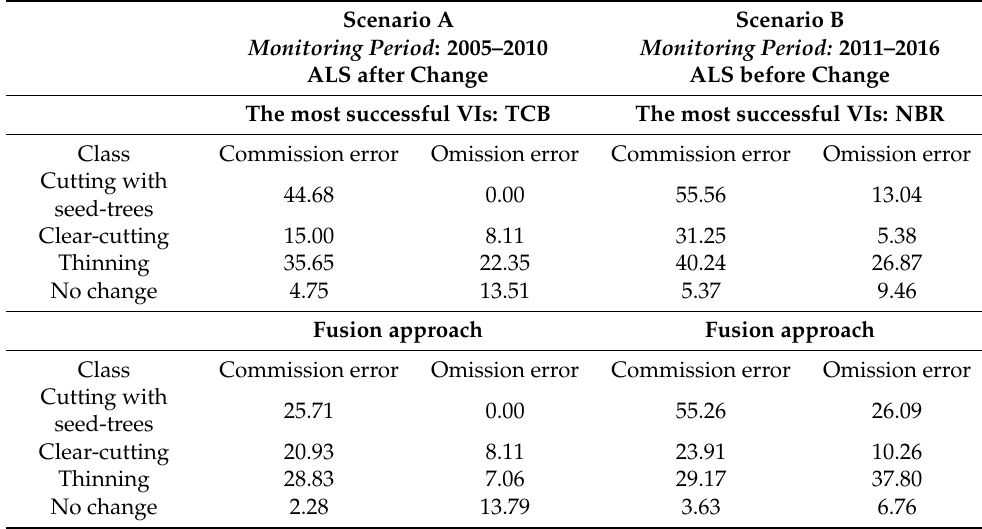
Figure 9. Commission and omission errors of the fusion change classification approaches. ( A ): Sce- nario A , when ALS data were acquired at the end of the monitoring period ; ( B ): scenario B , when ALS data were acquired at the beginning of the monitoring period . Table 2. Validation of the best change classifications performed in the study area for each scenario of monitoring period and for the fusion results of all the VIs used in this study. Errors units are %.